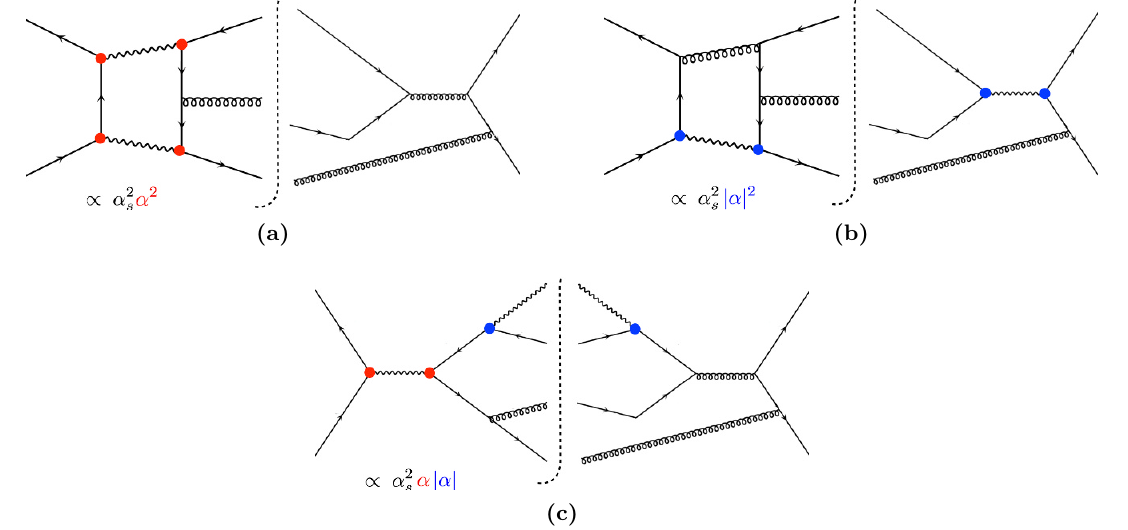
Figure 5. Representative virtual (panels (a) and (b)) and real (panel (c)) contributions to the q (cid:22) q ! q 0 (cid:22) q 0 g partonic cross section. The (cid:12)gure highlights the coupling-constant combinations relevant to each contribution. See the text for